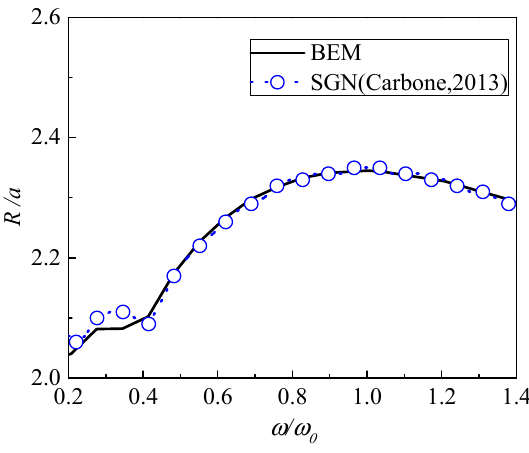
Figure 5. MWR along the vertical seawall of different frequencies.